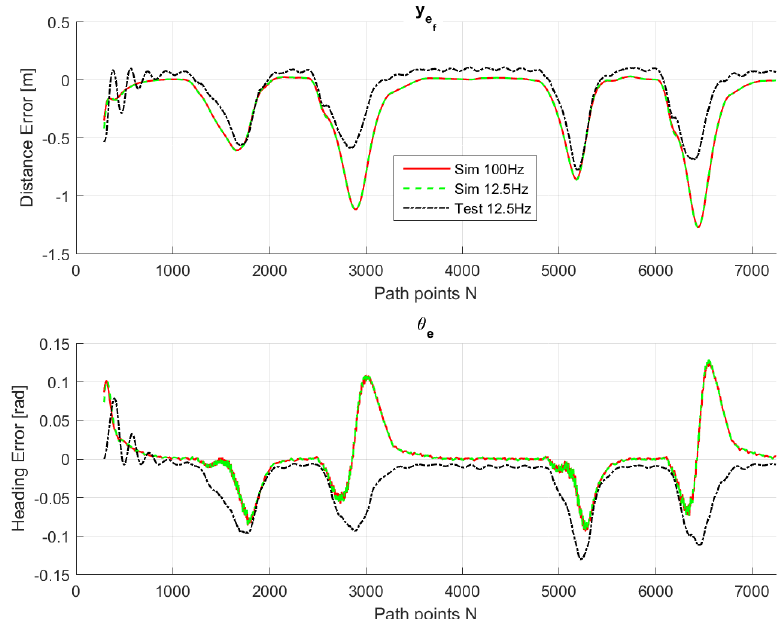
Figure 11. Lateral control inputs for simulations and test drive.